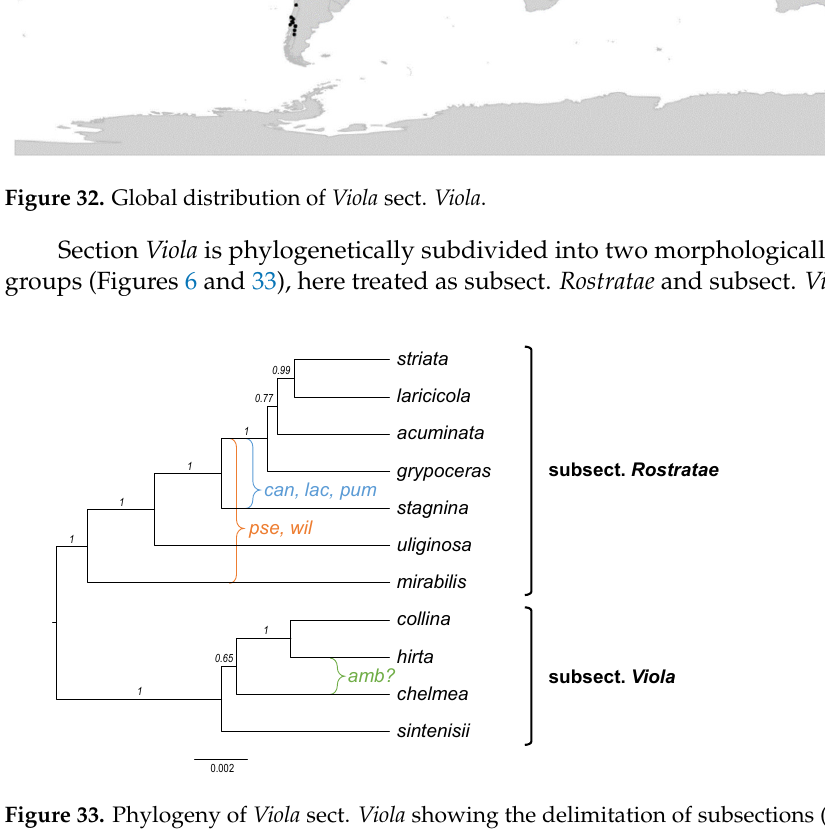
Figure 33. Phylogeny of Viola sect. Viola showing the delimitation of subsections (4 x ) with known allopolyploids (8 x ) superimposed, based on concatenated sequences of eight nuclear gene loci ( GPI-C , GPI-M , ITS-C , ITS-M , NRPD2a-C , NRPD2a-M , SDH-C , and SDH-M ). Outgroups have been pruned. The ages and placements for polyploids are not to scale. Branch support is given as posterior probabilities. Abbreviations: amb = V. ambigua ; can, lac, pum = V. canina , V. lactea , and V. pumila ; pse, wil = V. pseudomirabilis and V. willkommii .